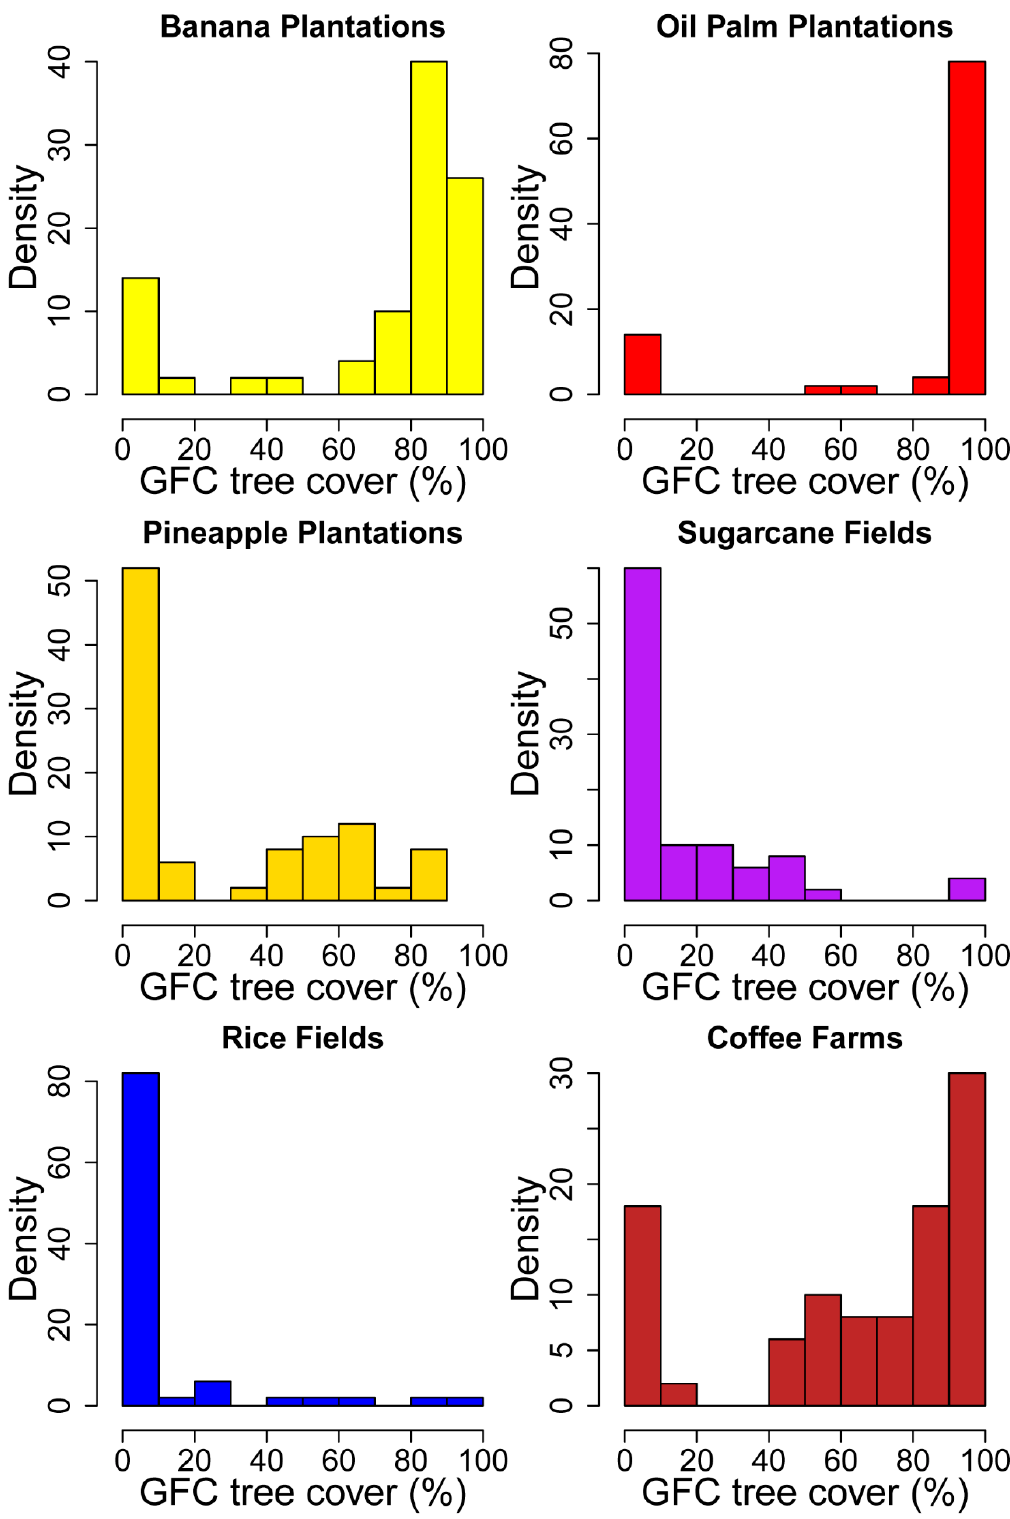
Figure 9. Histograms of GFC treecover for the top six crops in Costa Rica. The x -axis shows bins of GFC estimated percent tree cover and the y -axis is the percentage of agricultural testing points ( n = 50 per crop type) that fall within each tree cover bin.